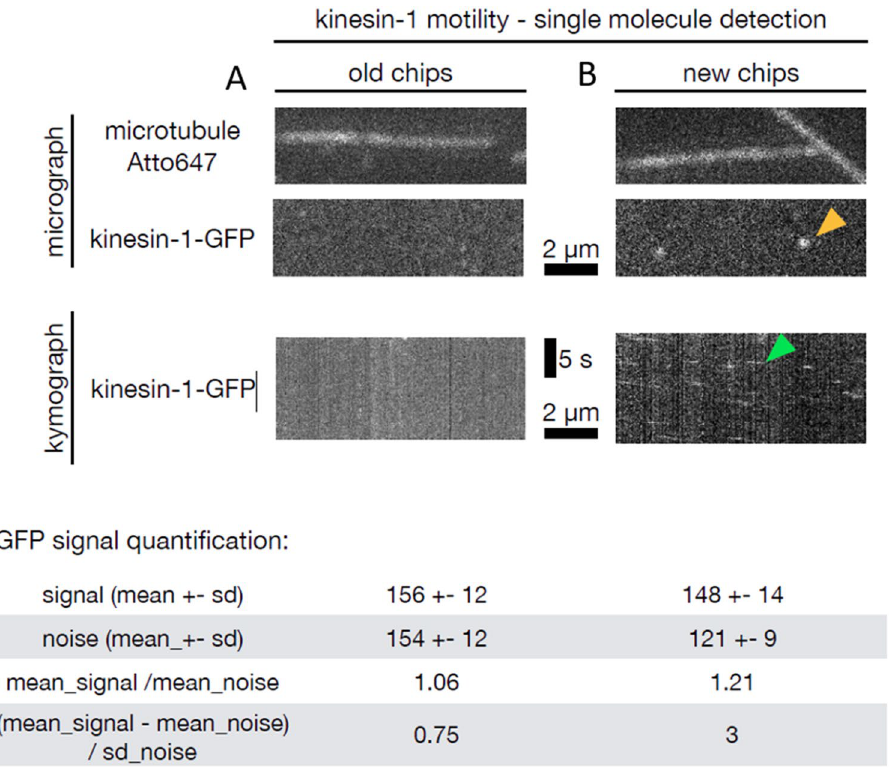
Figure 5. TIRF results from the (left) chip made from the conventional substrate and (right) an improvement once the SOI-based chip was used. Microtubule is detectable in both chips. Single kinesin-1-GFP molecules (in micrograph and kymograph indicated by orange and green arrowheads, respectively) can be detected only in the SOI-based chips.